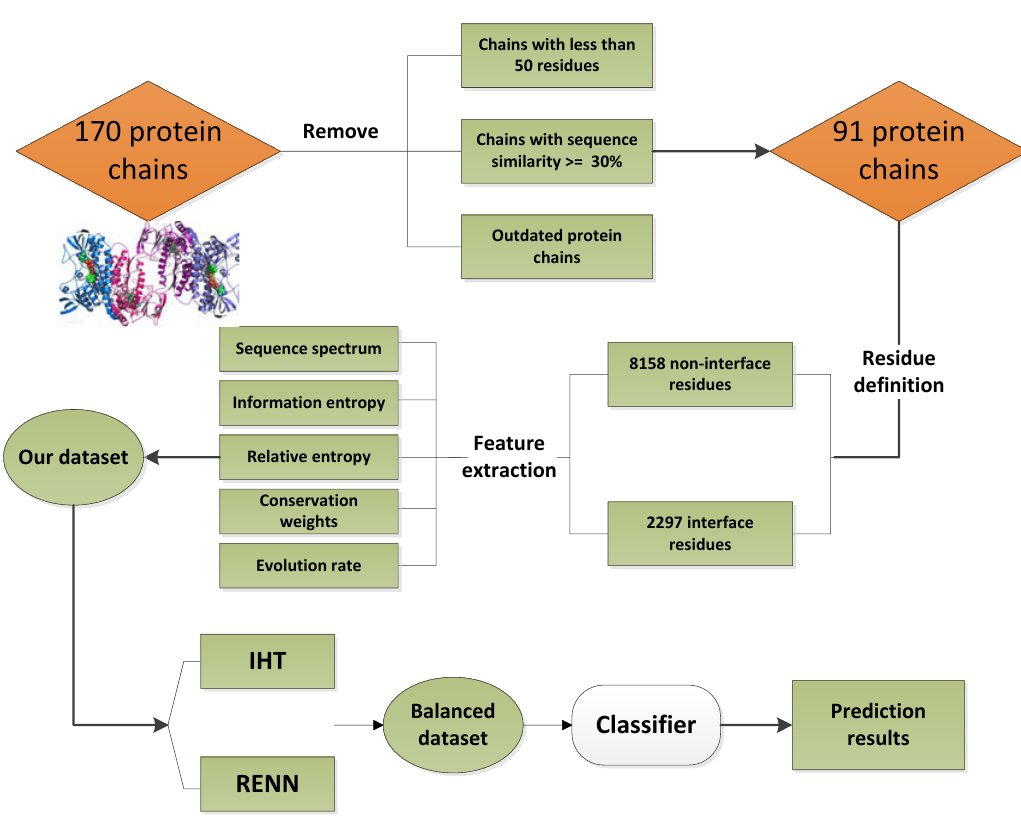
Figure 5. The flowchart of our method.